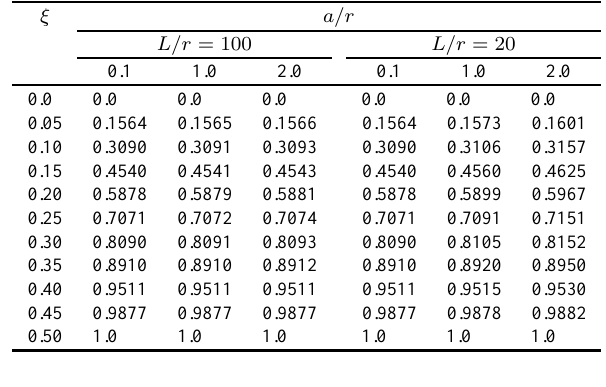
Table 1 Nonlinear first mode shape for simply supported beams